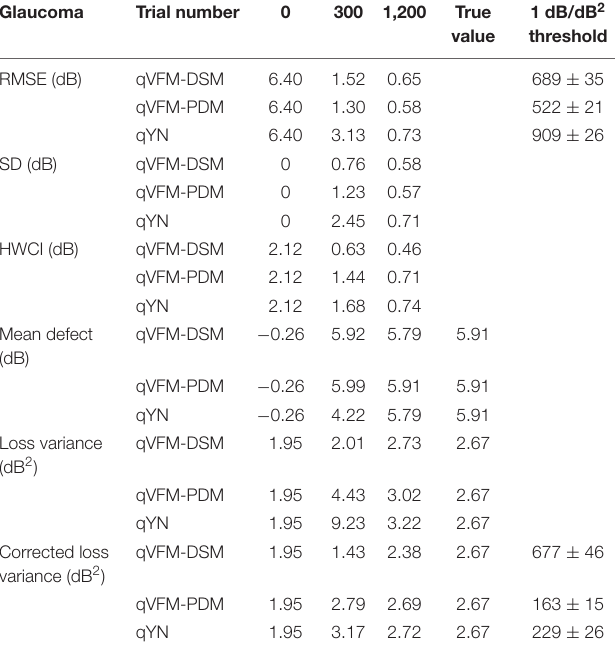
The corresponding true values are listed in the sixth column. Trial numbers needed to achieve 1 dB RMSE and 1 dB 2 within the corrected loss variance are listed with their SD in the last